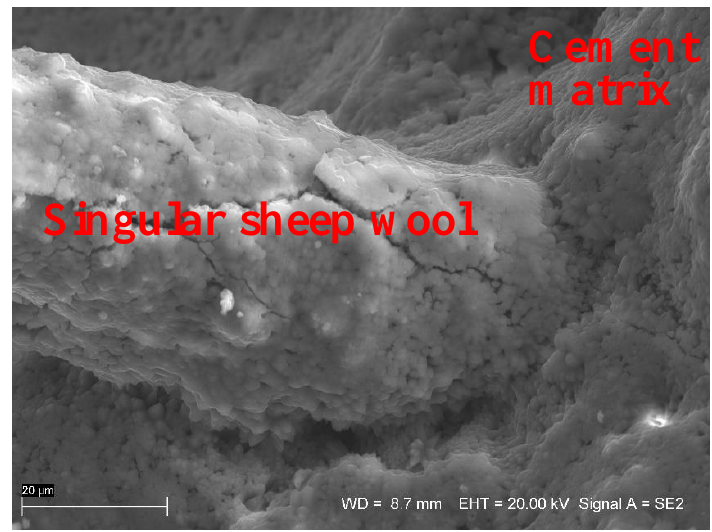
Figure 7. SE image of the sheep wool fibre—interface—cement matrix, scale bar = 20 µm.